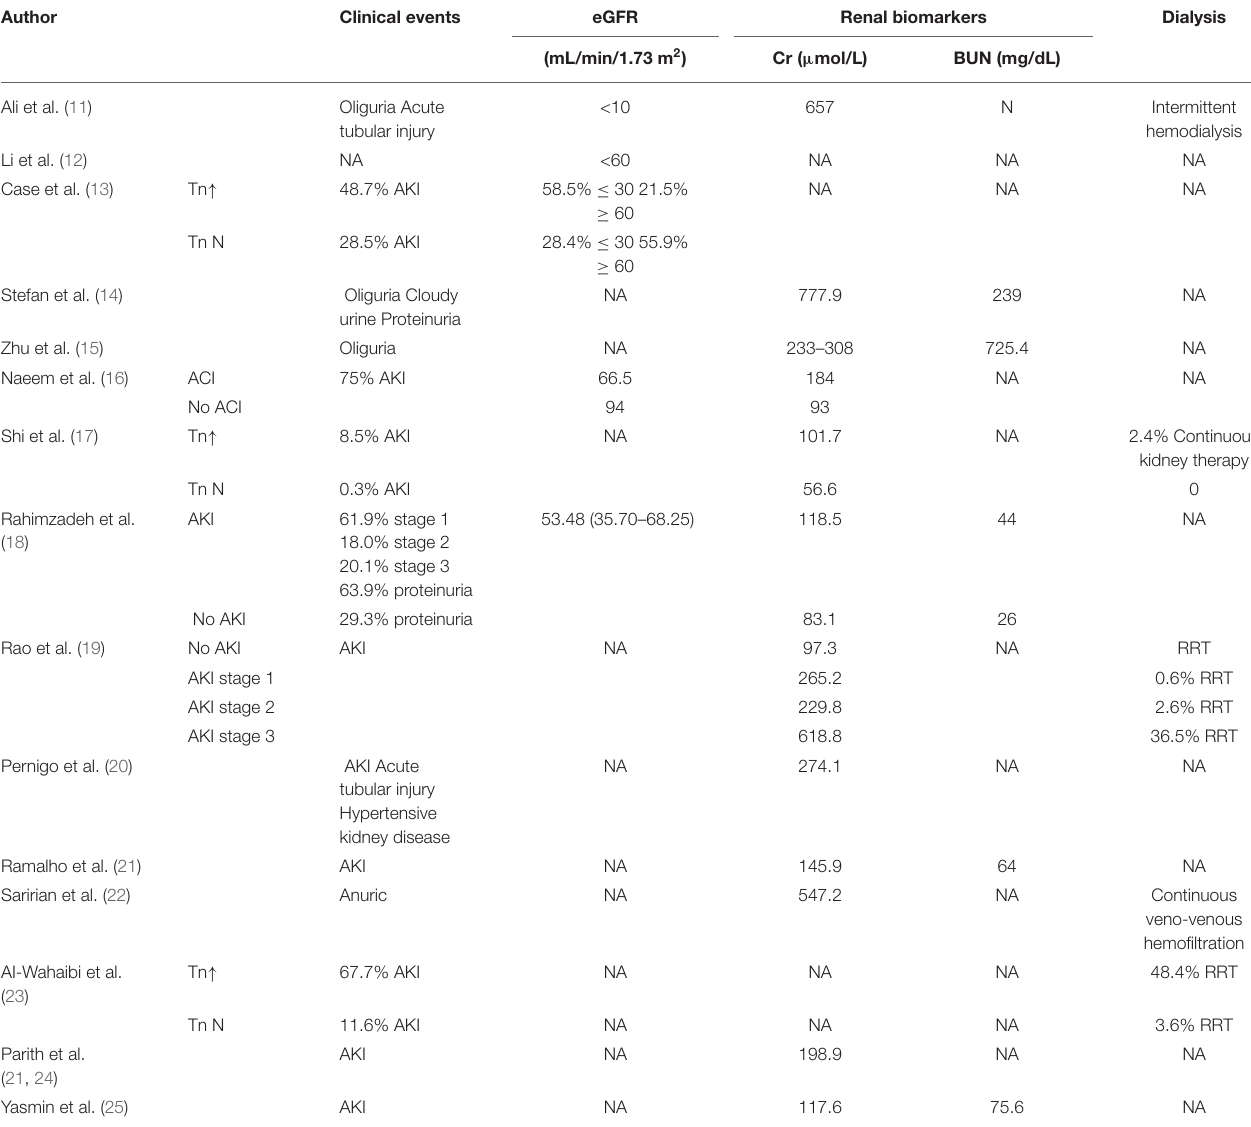
TABLE 3 | Clinical and laboratory findings of the kidney in COVID-19 patients with cardiac and renal